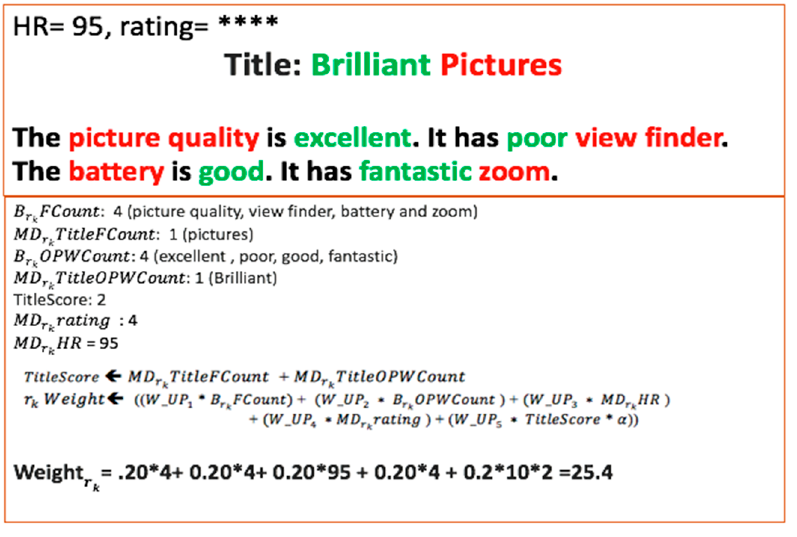
Figure 9. An example of review weight